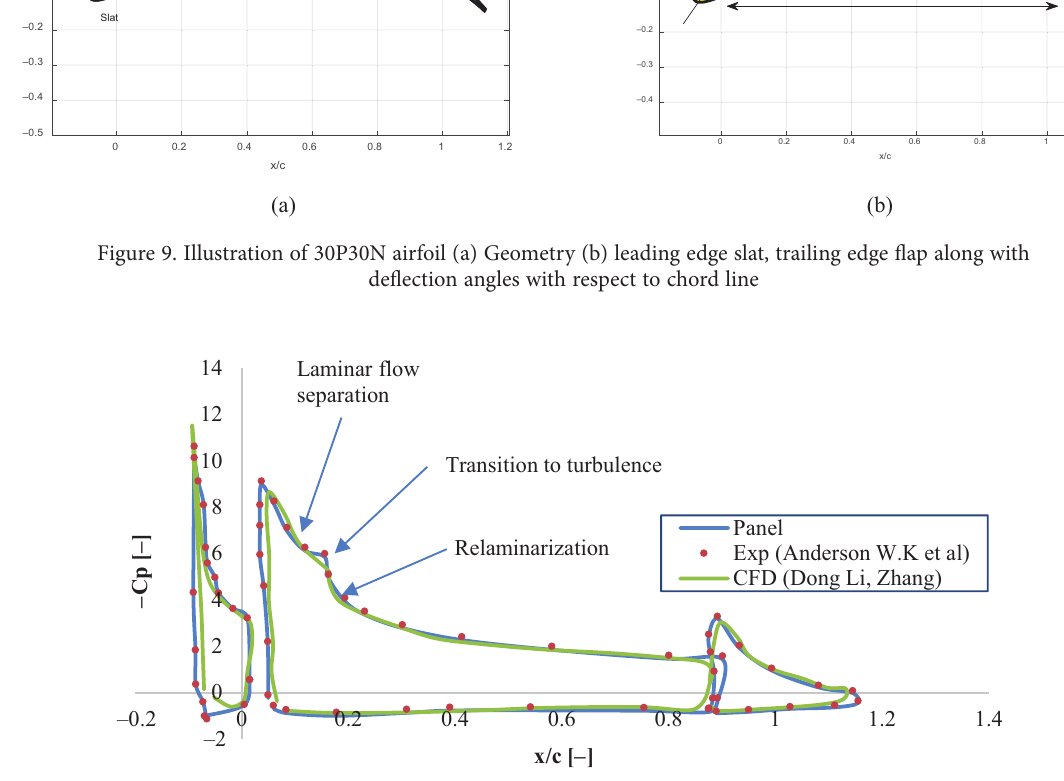
Figure 10. Comparison of pressure coefficient distribution computed using 2D panel method for 30P-30N airfoil with CFD results of Dong and Zhang (2012) and experiment results of Anderson et al. (1995) at 16° angle of